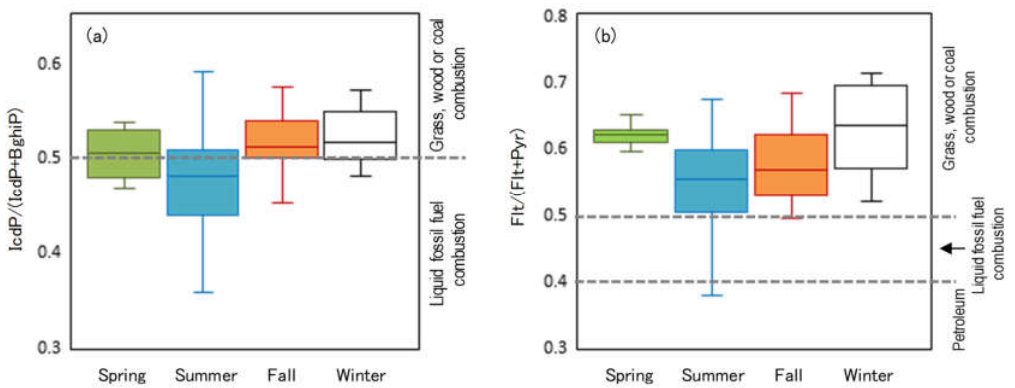
Figure 5. Ranges of the diagnostic ratios of the forest site for each season, excluding outliers. The upper and lower ends of the bars represent the upper and lower limits of the observed values. The upper and lower ends of the boxes represent the third and first quartiles. The lines intersecting the boxes represents the median values: ( a ) ranges of IcdP/(IcdP+BghiP); ( b ) ranges of Flt/(Flt+Pyr).